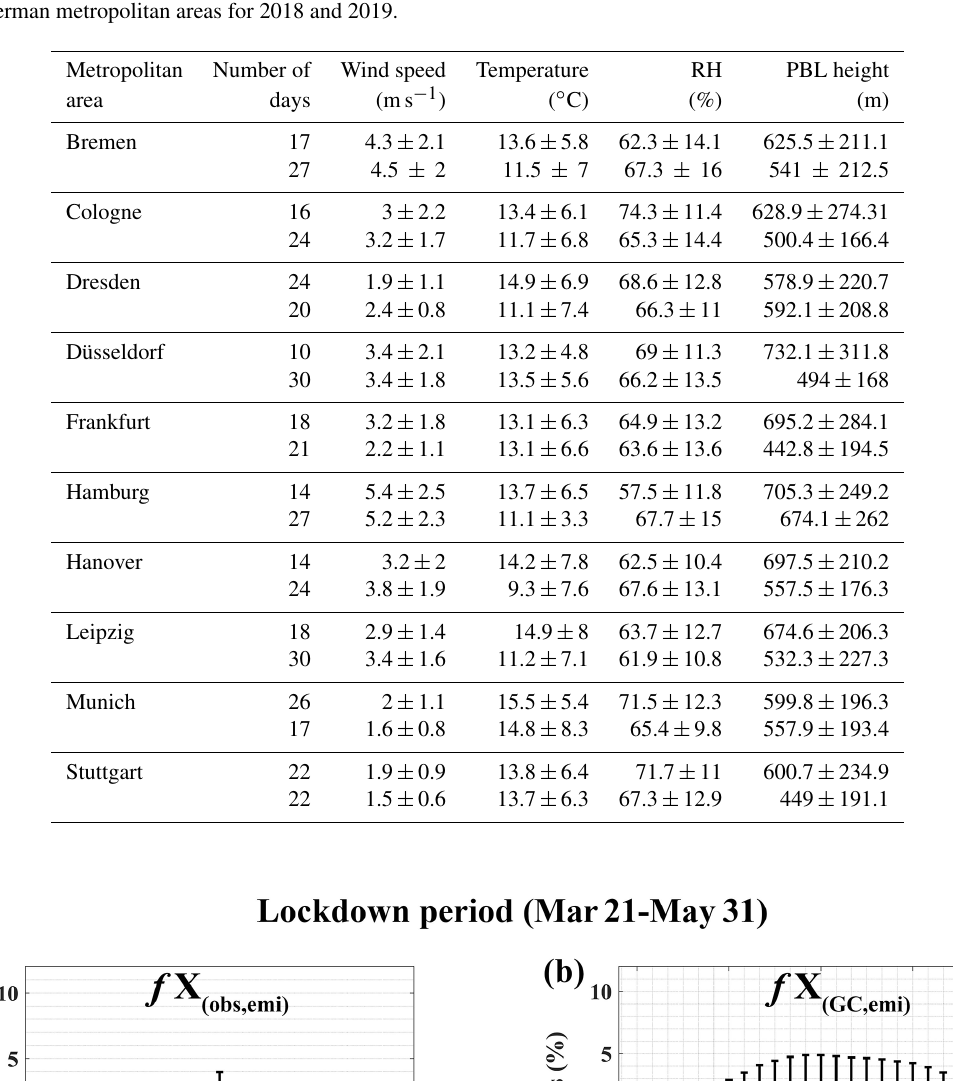
Table C1. The statistical distribution of meteorological parameters for the cases Independent (each row top) and Simultaneous (each row bottom) in 10 German metropolitan areas for 2018 and 2019.